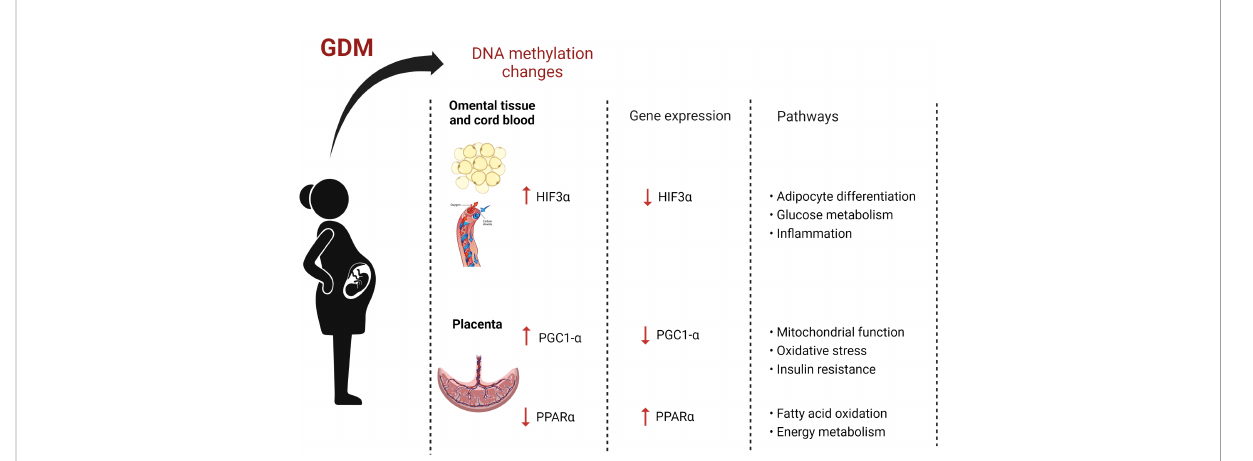
FIGURE 2 The effects of gestational diabetes on maternal DNA methylation (Image created with